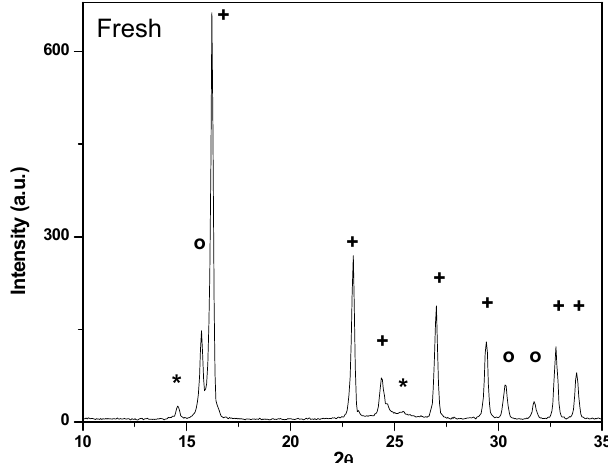
Figure 3. Diffraction pattern of the AF sample: ( + ) AlF 3 (H 2 O) 3 ICSD 416689 (83 wt %); ( o ) Al 2 [(O H) x F (1-x) ] 6 (H 2 O) y COD 1000086 (12.9 wt %) and ( * ) β -AlF 3 ICSD 202681 (3.2 wt %).